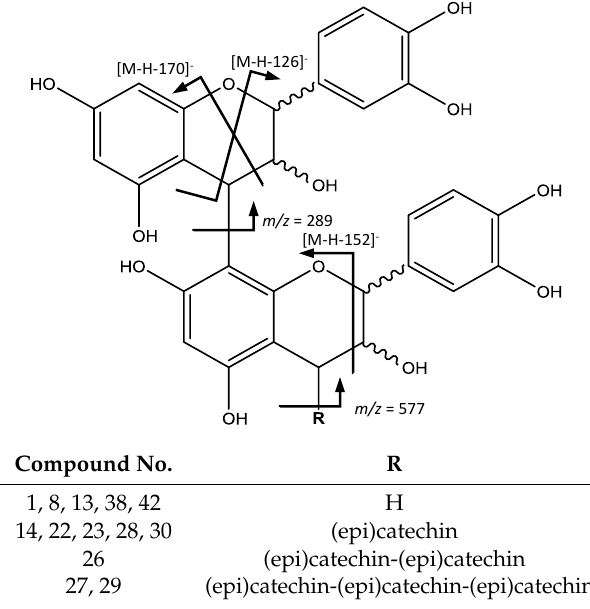
Figure 5. Proanthocyanidin B-type structure and main fragments.